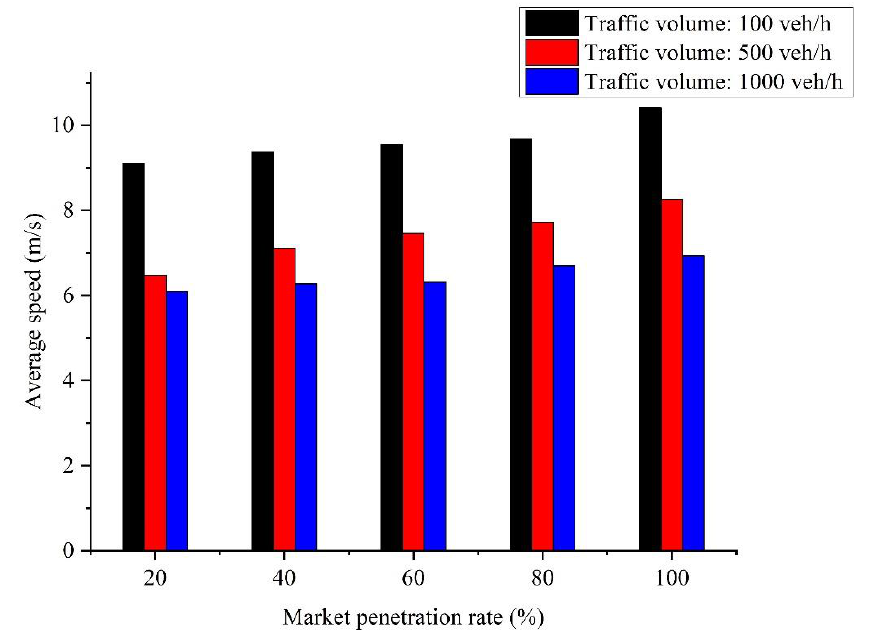
Figure 8. Average speeds with different market penetration rates and real traffic volumes.